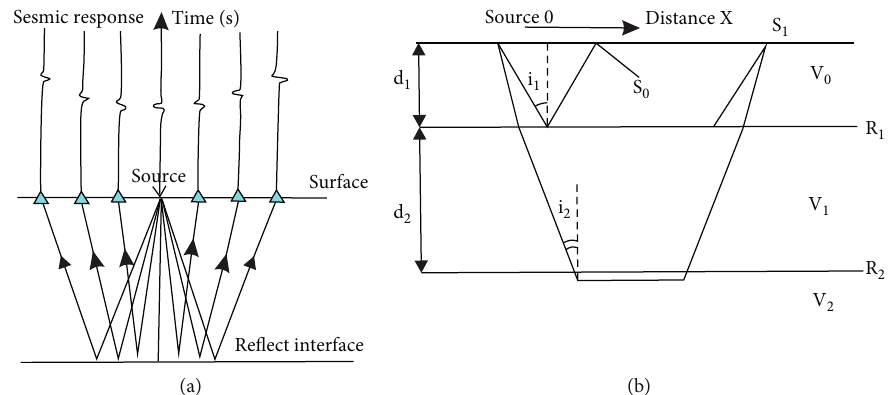
Figure 3: Sketch map of seismic exploration: (a) the re fl ection method and (b) the refraction method.